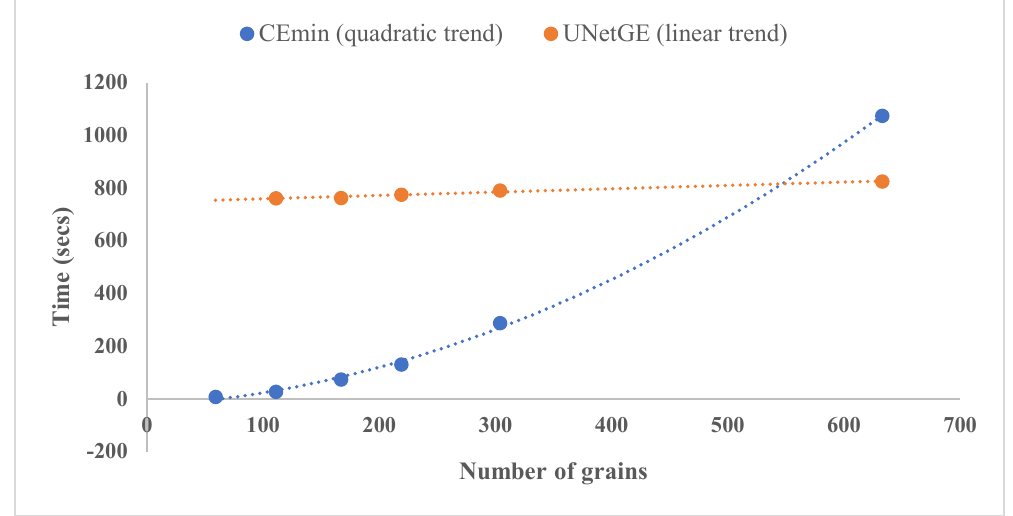
Figure 12. A comparison of time to extract grains between CEmin and UNetGE.